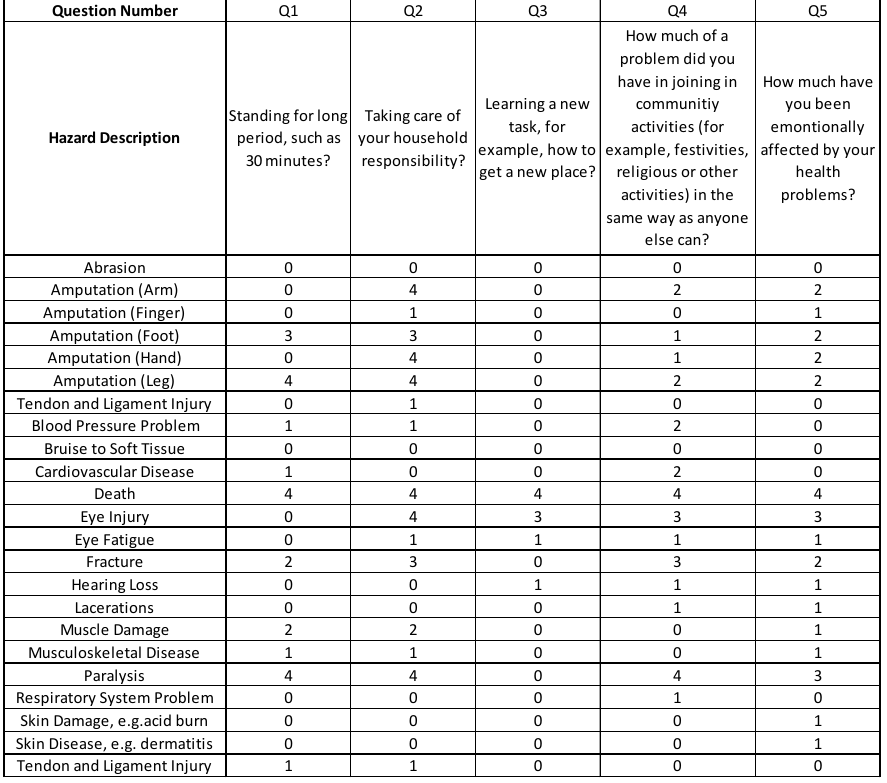
Figure 8. WHODAS score for lathe work.